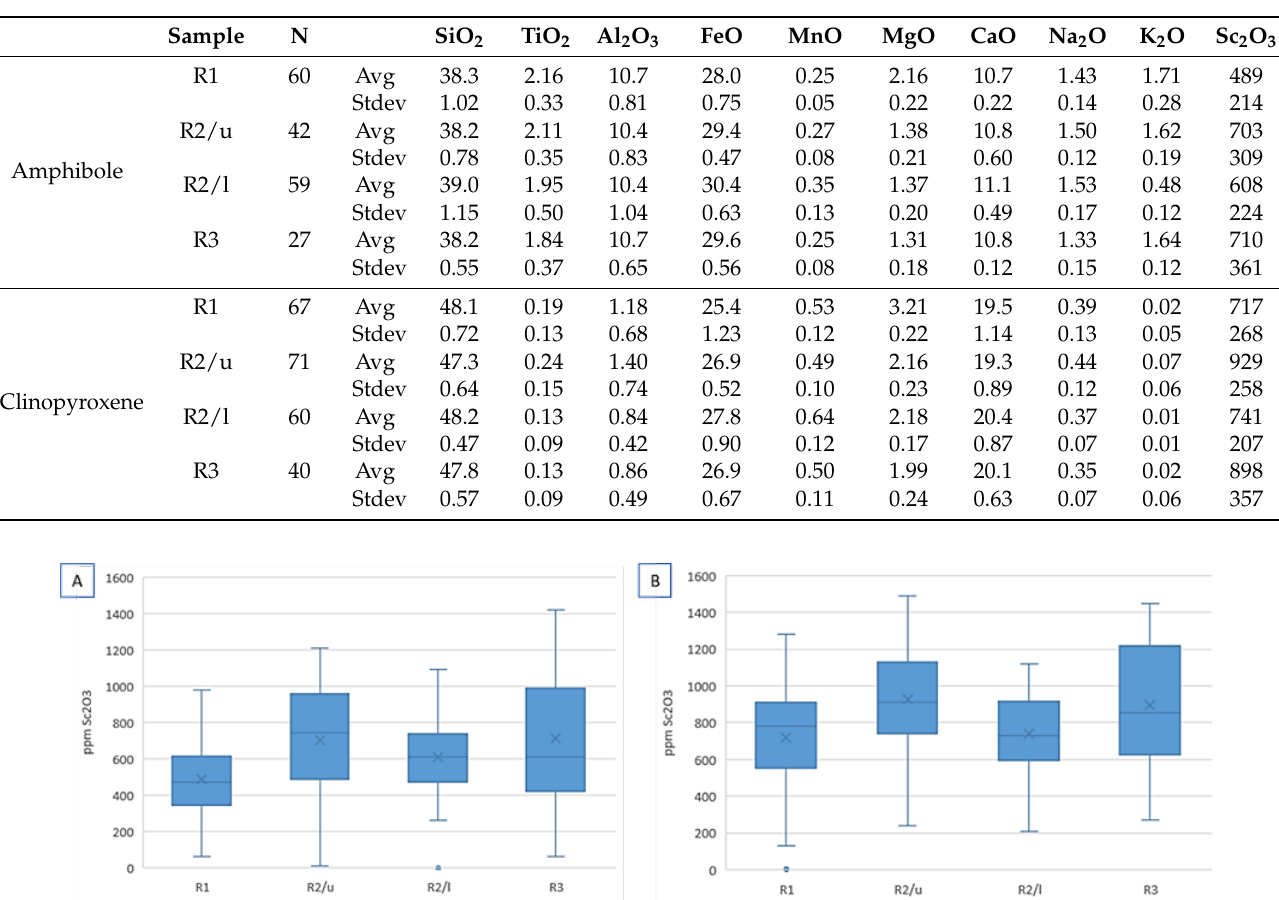
Table 5. Average electron microprobe compositional data (Sc 2 O 3 in ppm, other oxides in wt%) for amphibole and clinopyroxene in Kiviniemi composite samples (N = number of point analyses).